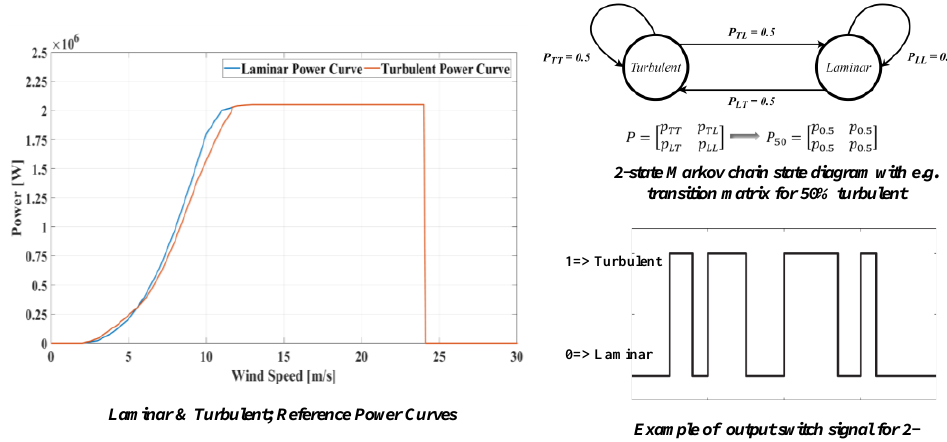
= f ) ) and turbulent ( P ω ( ω i laminar i